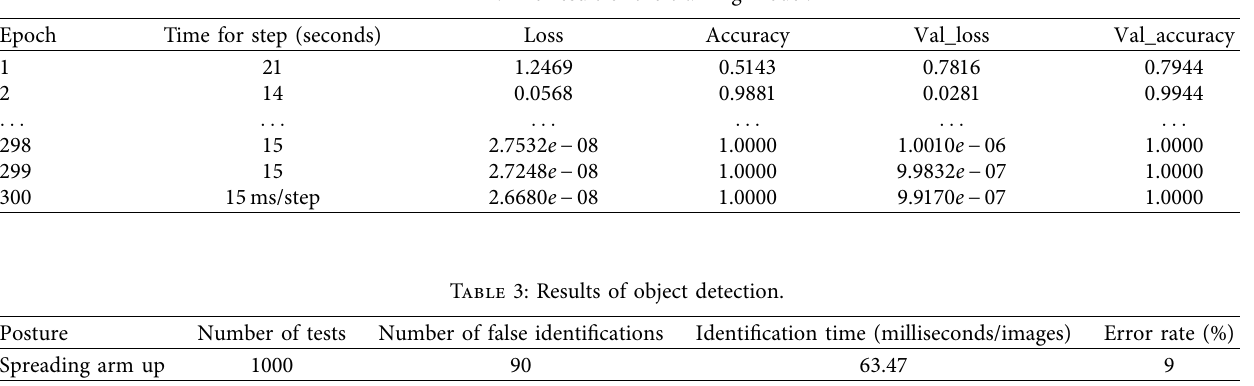
Table 2: The result of the training model.